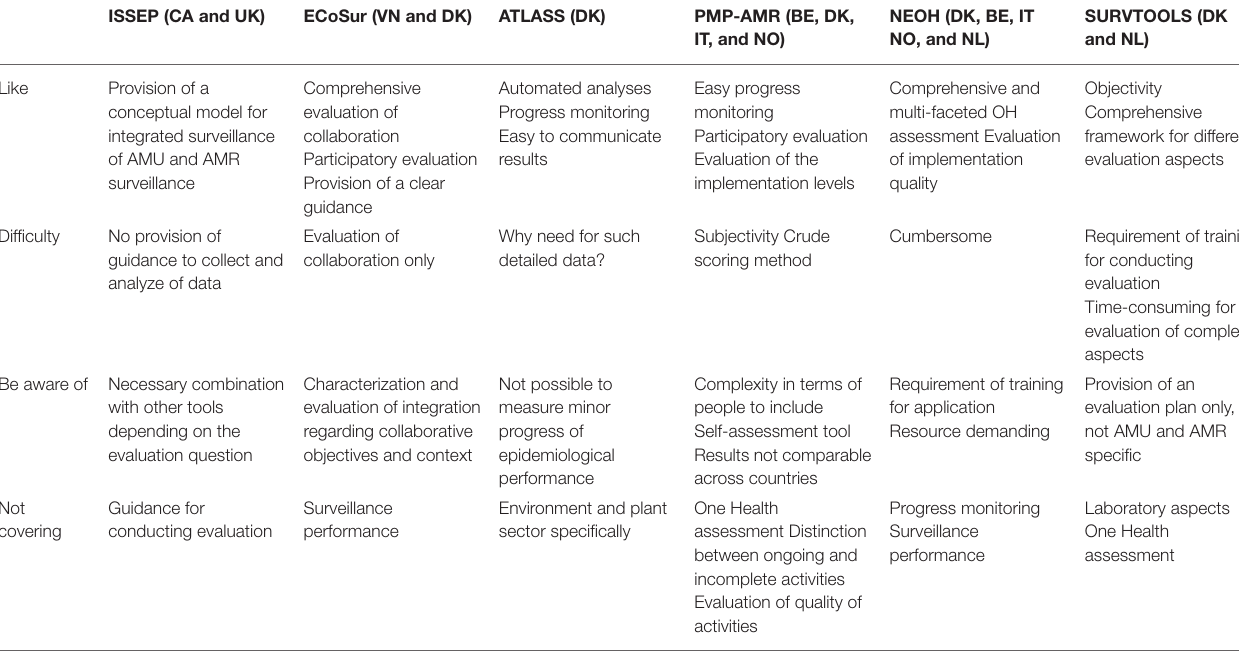
TABLE 5 | Synthesis of phrases provided in the SWOT analysis of six different evaluation tools used in eight country-based case studies. ISSEP (CA and UK)